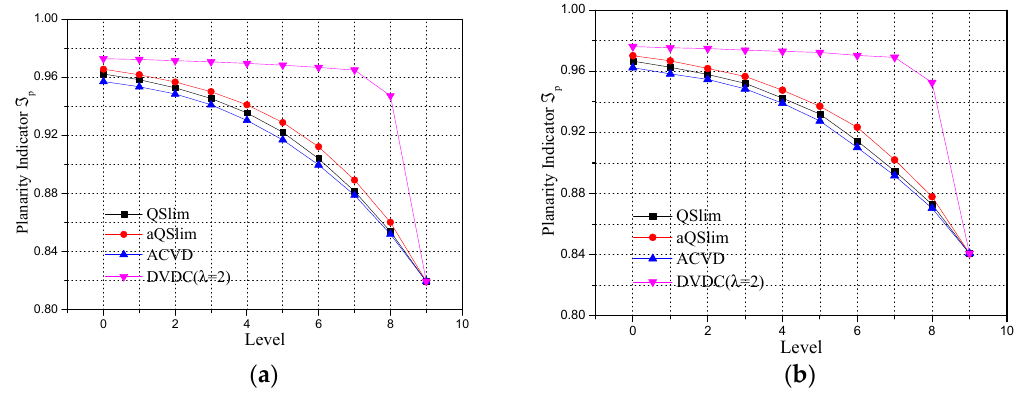
Figure 14. As expected, aQSlim also performs better than QSlim in terms of the planarity of planar surfaces. However, DVDC ( λ = 2) unexpectedly makes planar surfaces more planar, even when the simplification rate is low (the level of LOD is high). ( a ) Scenery 1; ( b ) Scenery 2.